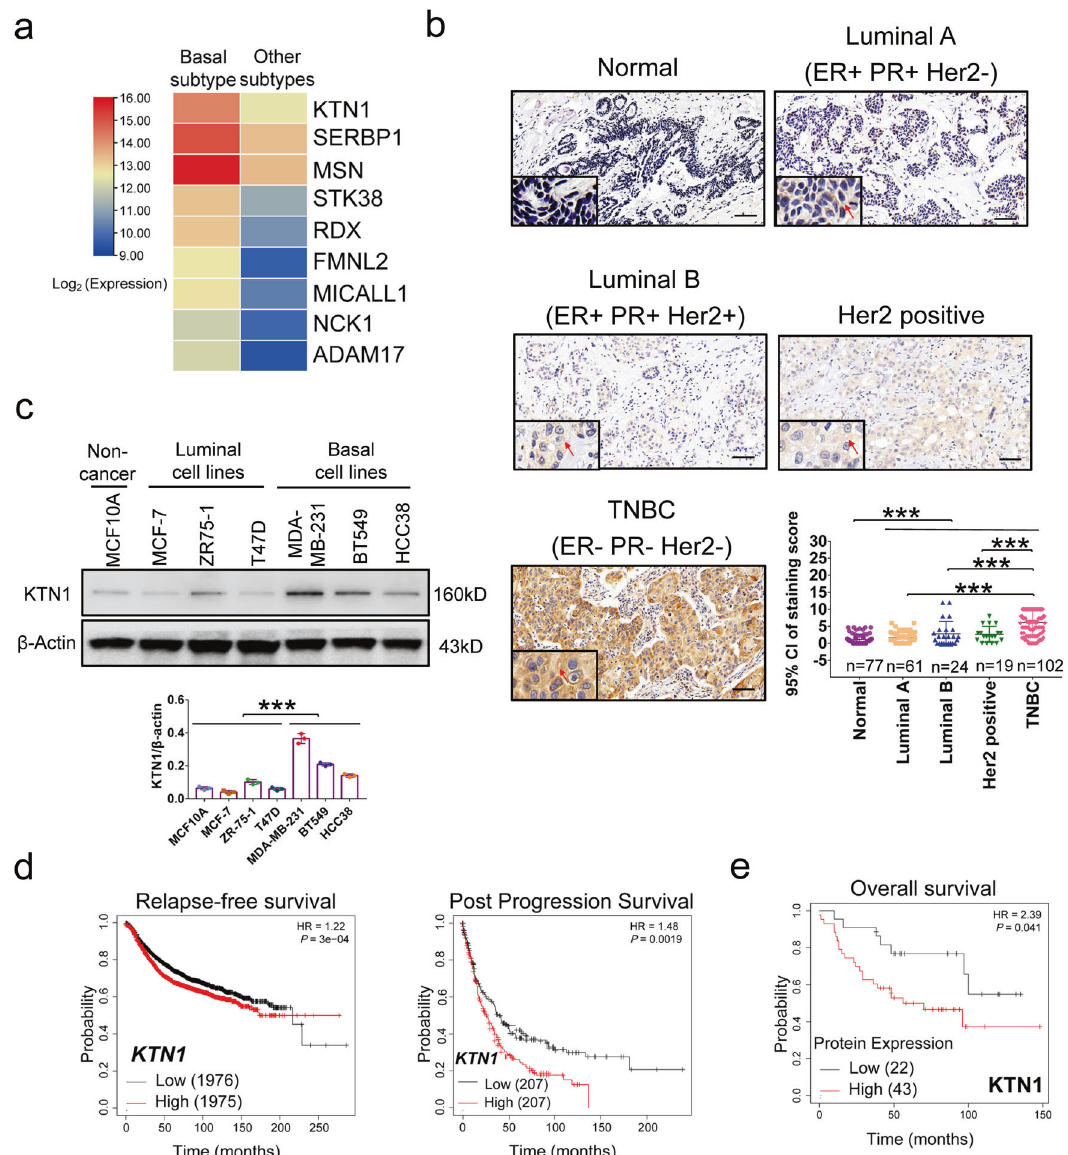
Fig. 1 High KTN1 expression associated with clinical outcomes in TNBC tissues and cells. a Representative up-regulated genes in GO pathways. b Immunohistochemistry (IHC) staining analysis of KTN1 protein in different subtypes of BCa. Normal, n = 77; Luminal A, n = 61; Luminal B, n = 24; Her2, n = 19; TNBC, n = 102. Data were plotted as the means of 95% con fi dence interval ± s.d. c Western blot analysis of KTN1 expression. Below shows the densitometric quanti fi cation of KTN1 expression relative to MCF10A. Kaplan – Meier analyses of relapse-free survival, post progression survival of breast cancer patients from d ‘ high ’ and ‘ low ’ KTN1 mRNA expression from Kaplan-Meier plotter dataset e ‘ high ’ and ‘ low ’ KTN1 protein expression from Tang_2018 dataset. One-Way ANOVA and Dunnett ’ s multiple comparison test were used to analyze the data. * P < 0.05, ** P < 0.01, *** P < 0.001. Scale bars, 100